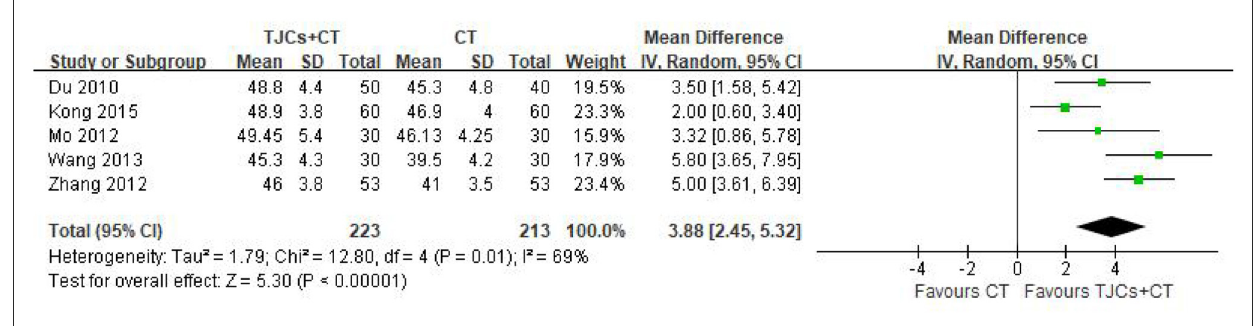
FIGURE4 Forest plot of Peroneal nerve MNCV (m/s).